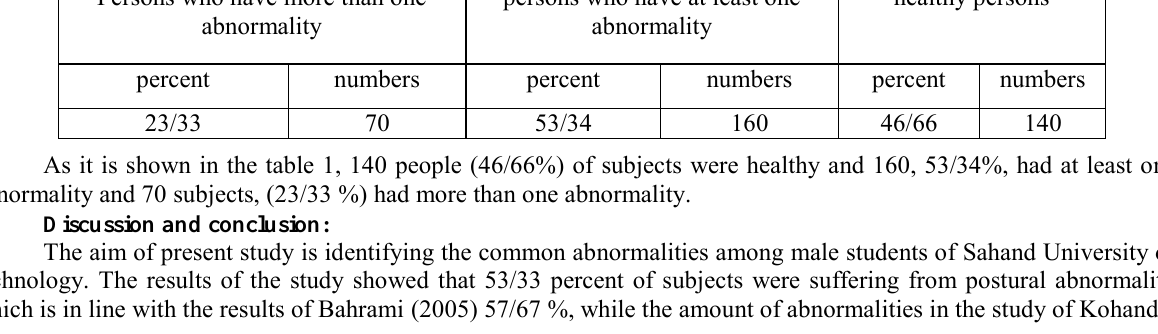
Table 1. Male student’s frequency of Sahand Technology University, based on amount of postural abnormalities spread